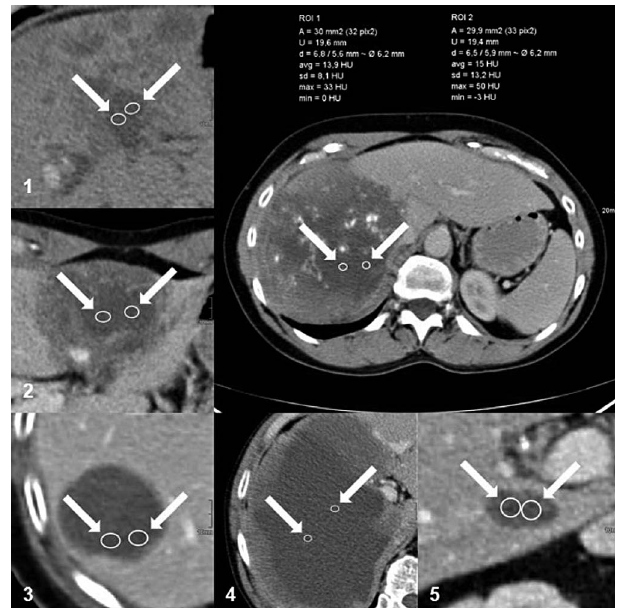
Figure 2. Example of density measurement in the cystoid portions of AE lesions on CT. Left and below: in each case, two enlarged ROIs within the cystoid portions of AE lesions of different primary morphological types: (1) Type I “ diffuse in fi ltrating with cystoid portion ” ; (2) Type II “ primarily circumscribed tumour-like with cystoid portion ” ; (3) Type IIIa “ primarily cystoid intermediate without solid portion at the edge ” ; (4) Type IIIb “ primarily cystoid widespread with solid portion at the edge ” ; (5) Type IV “ small cystoid/metastatic ” . Above right: two ROIs with surface data and HU values (max, min, mean and standard deviation) within the cystoid portion of an AE lesion involving both lobes of the liver. (AE = alveolar echinococcosis; CT = computed tomography; HU = Houns fi eld unit; ROI = region of